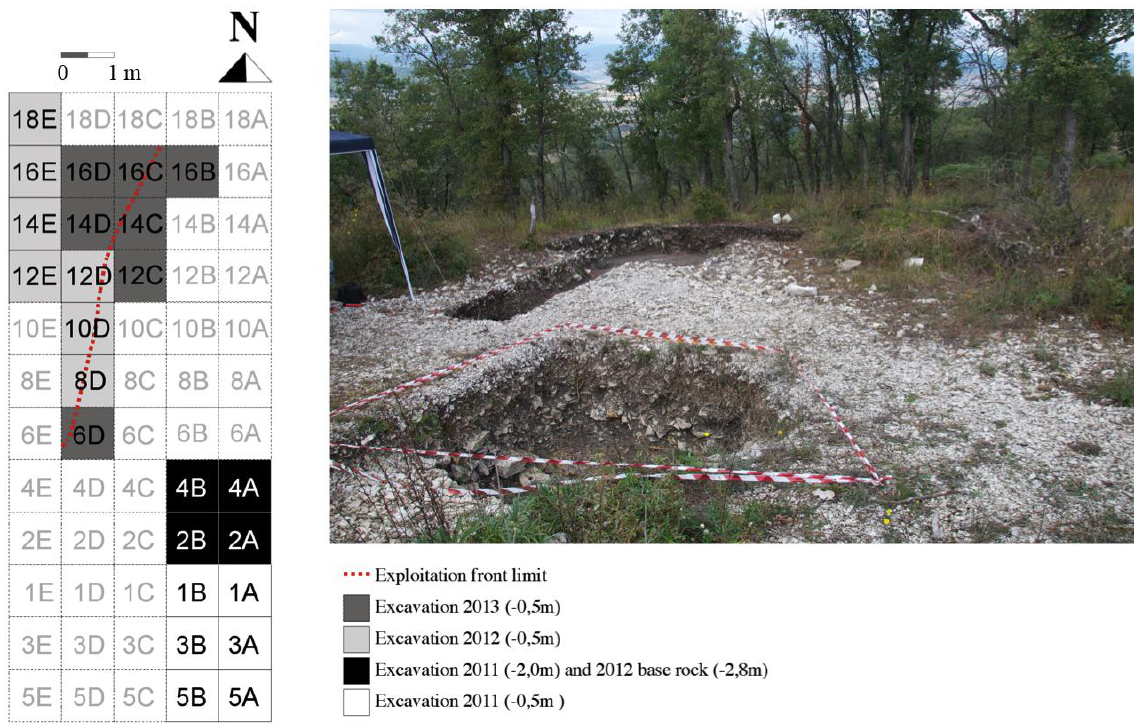
Figure 11. A plan view of the excavation and a photographic view of the